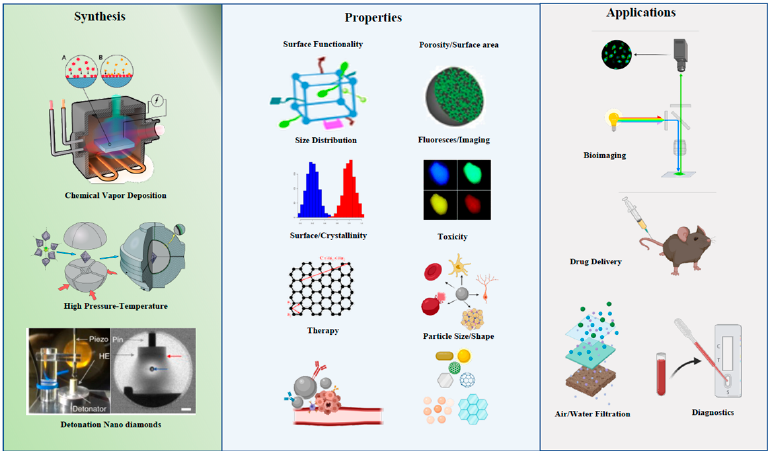
Figure 1. Synthesis, properties and applications of carbon nanoparticles.